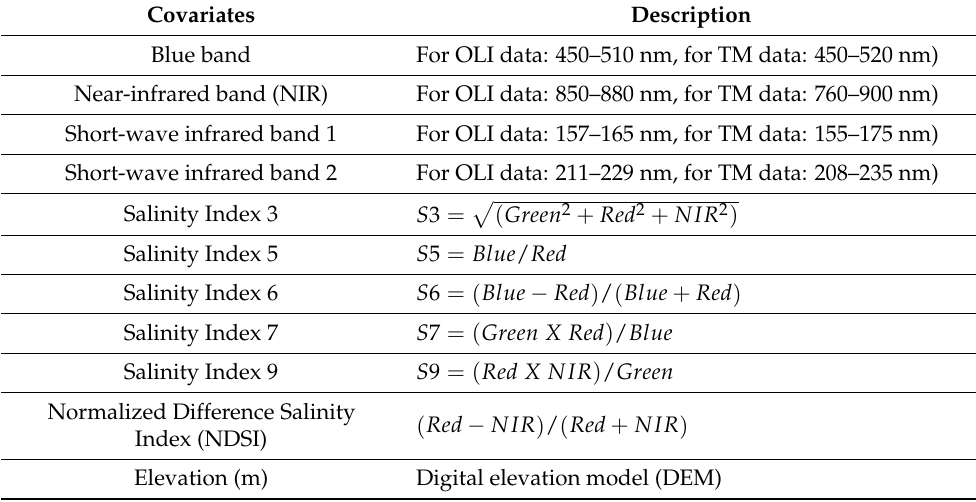
Table 2. Covariates used for generating salinity